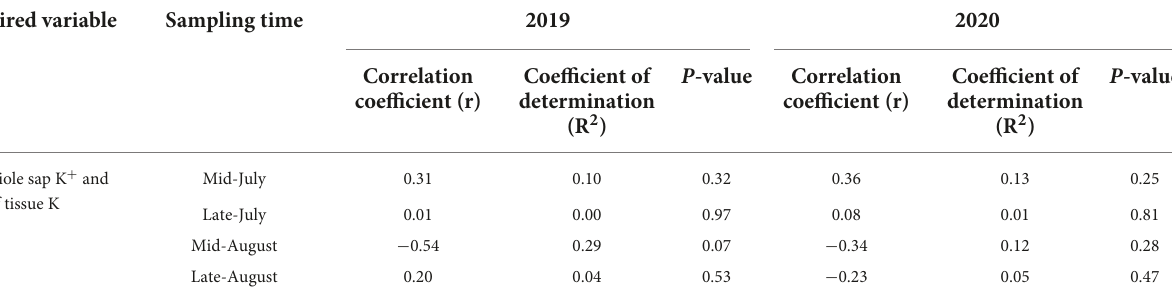
TABLE 6 Pearson correlation coefficients (r), linear regression coefficients of determination (R 2 ), and the P -values of paired variables by sampling time in 2019 and 2020. Paired